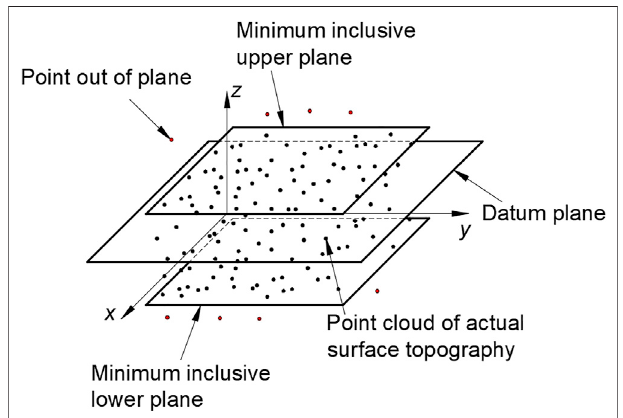
FIGURE 12 | Filtering principle of surface topography point cloud